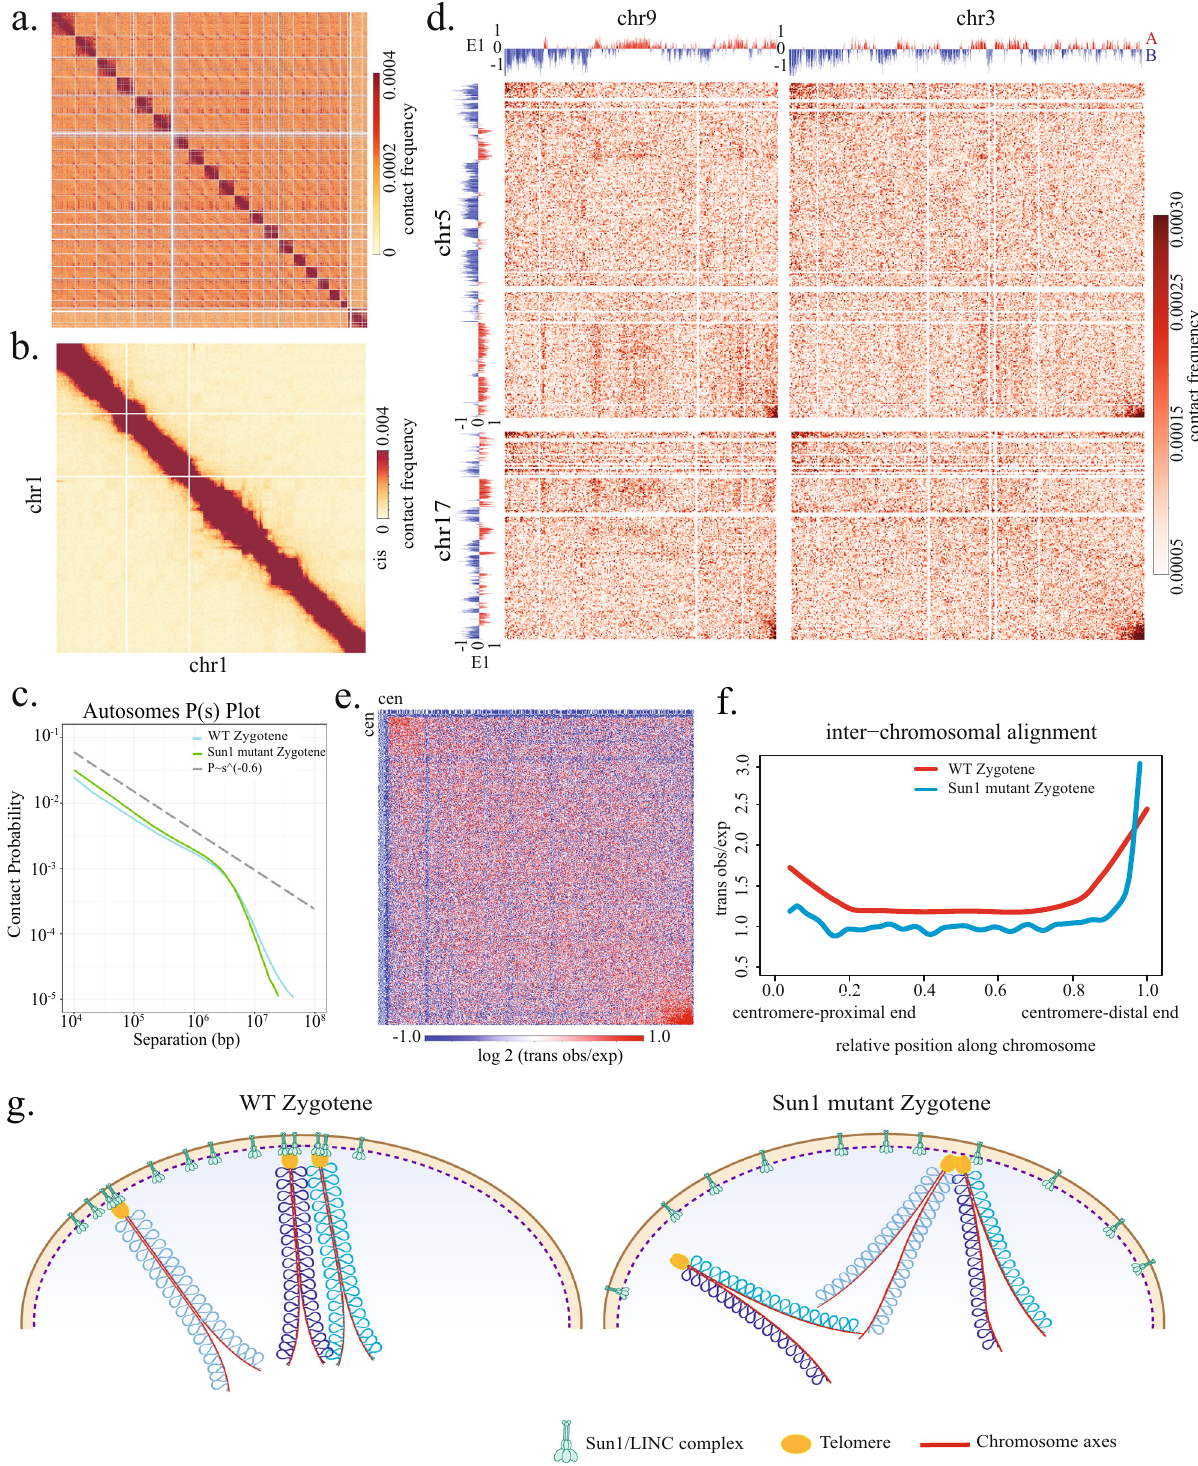
Fig. 7 Telomere – LINC complex association is required for chromosome end alignment over a substantial range. a Genome-wide Hi-C interaction heatmaps binned at 1 Mb resolution for Sun1 W151R/W151R mutant zygotene spermatocytes. b Chr1 interaction heatmaps binned at 1 Mb resolution for Sun1 W151R/W151R mutant zygotene spermatocytes. c P ( s ) curve of Sun1 W151R/W151R mutant zygotene spermatocytes exhibits a similar shape to wild-type zygotene spermatocytes. d Interaction heatmaps at 500 kb resolution showing trans observed interaction frequencies among chromosomes 3, 5, 9, and 17. Different chromosomes only exhibit association at the very tips of chromosomes. e Averaged trans observed/expected heatmaps of 171 pairwise combinations of autosomes in Sun1 W151R/W151R mutant zygotene spermatocytes. f Plots compare signals along the diagonals of the averaged trans heatmaps for wild-type and Sun1 W151R/W151R mutant zygotene spermatocytes. The inter-chromosomal alignment pro fi le abruptly drops off at the telomere- distal end. g Cartoons illustrate the effects of telomere association with the force-transmitting LINC complex on the alignment of chromosome